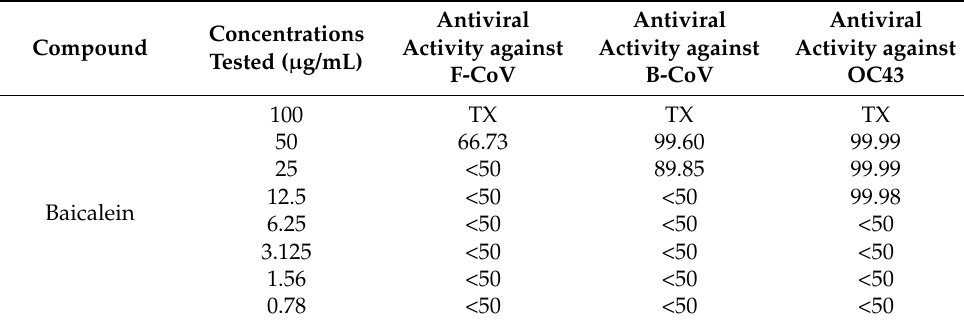
Table 3. Pan-coronavirus antiviral activity of Baicalein. Compound